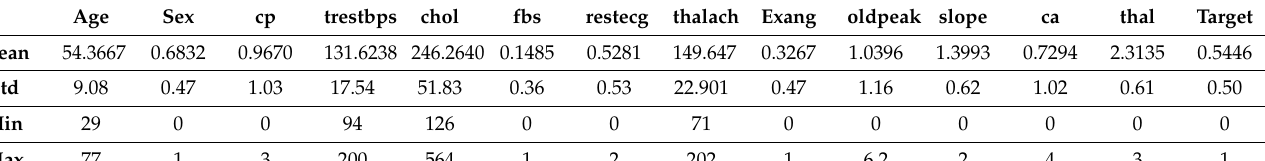
Table 5. The feature distribution of the Cleveland Heart Disease dataset.